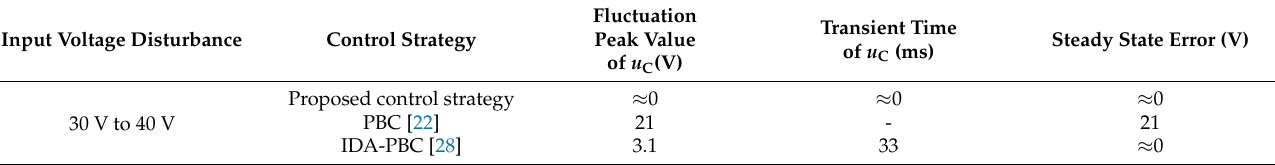
Table 2. Simulation results for u C of DDBC under different control strategies and input voltage disturbances.